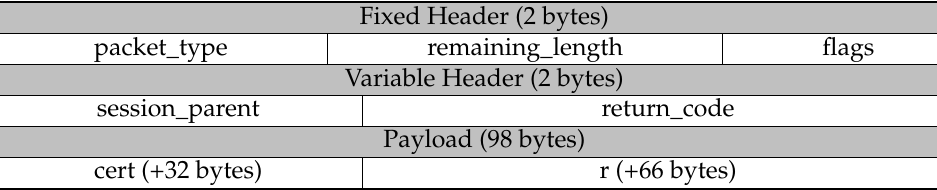
Table 2. MQTT modified connack packet.